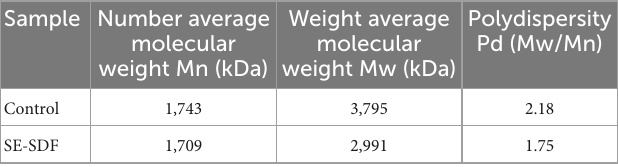
TABLE 5 Monosaccharide composition of soluble dietary fiber (SDF) from untreated and steam explosion (SE)-treated adlay bran. Monosaccharide content (g/100g)